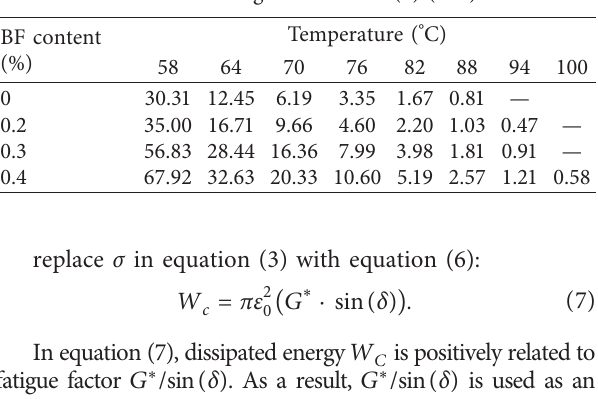
Figure 8: Rheological property. (a) Complex shear modulus G ∗ . (b) Phase angle δ . (c) Storage shear modulus G ′ . (d) Loss shear modulus G ″ . Table 5: Rutting factor G ∗ /sin ( δ )